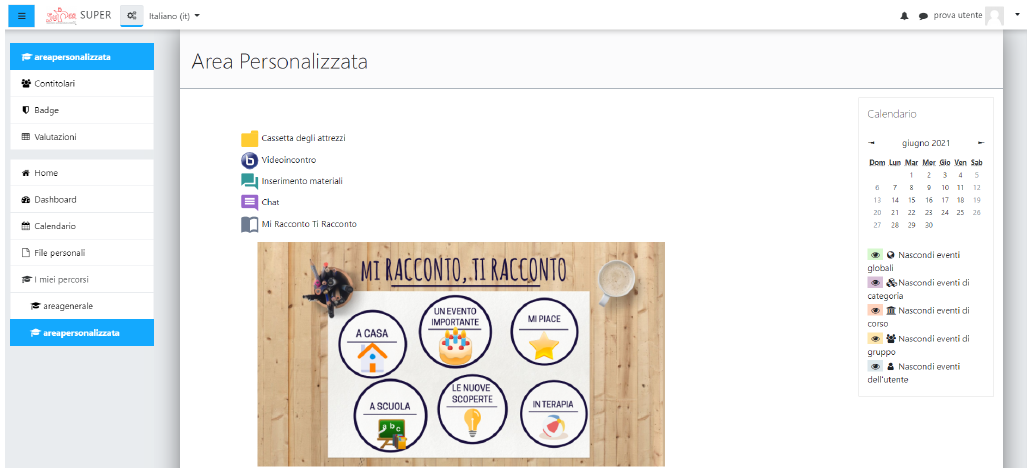
Figure 2. Screenshot of the initial page of the Personalized Area. The figure shows an overview of the Personalized Area, where useful communication and content sharing tools were